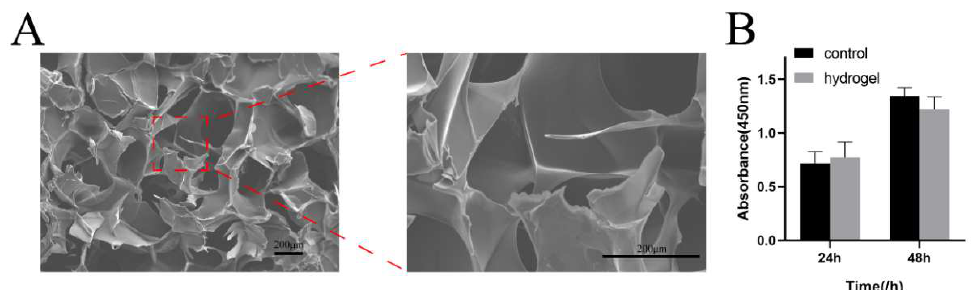
Figure 3. Characterization of hydrogels ( A ) SEM image of hydrogel scaffold ( B ) CCK-8 assay results of cytotoxicity test.